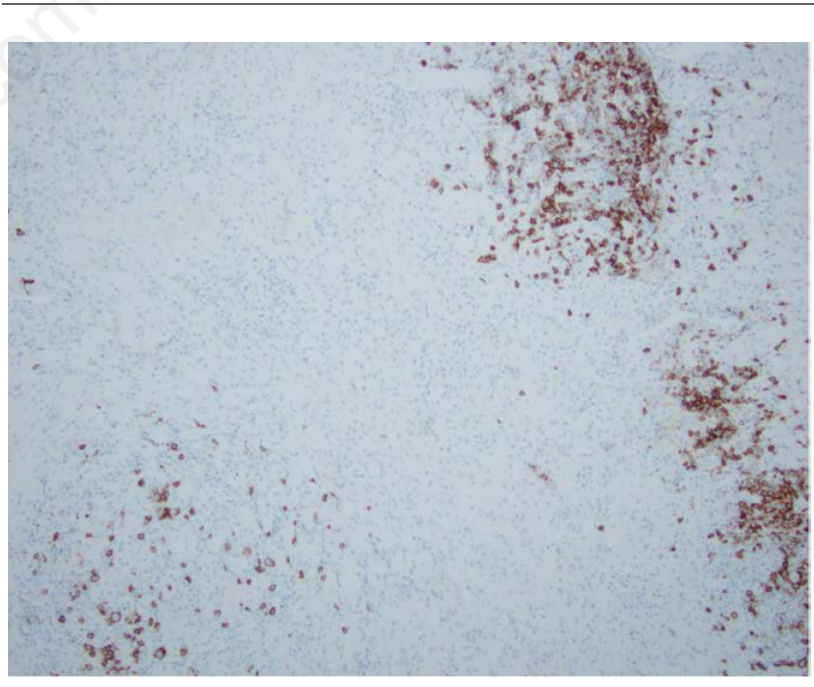
Figure 2. Positive CD20